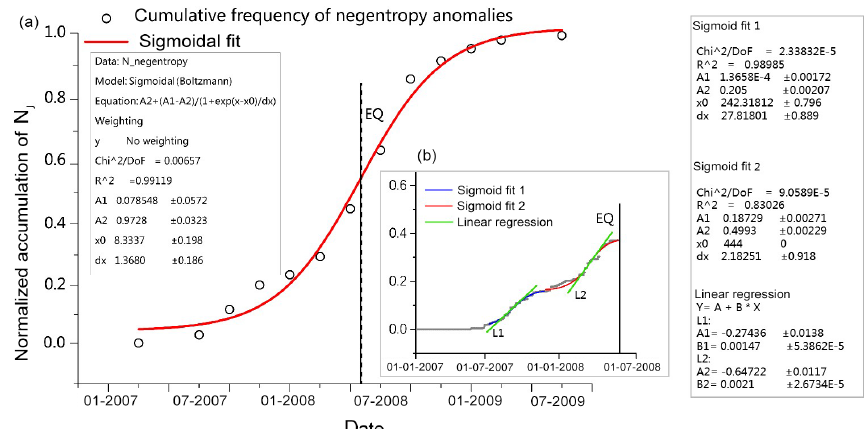
Figure 8. (a) Results of the long-term negentropy anomaly frequency for the Wenchuan earthquake at Guza station from 1 January 2007 to 30 June 2009. Each circle represents an anomaly negentropy for 2 months. The cumulative frequency of negentropy anomaly is represented. The earthquake day is represented as a black vertical dashed line. The red line is a sigmoid fit that underlines an inflection point (vertical solid line) that is close to the occurrence of the earthquake. (b) Results of the short-term negentropy anomaly frequency prior to the earthquake. Every grey point is an anomaly for 1d, and the blue and red lines are two segment sigmoid fit results. Two green lines represent the liner regression for the two phases; the first phase slope is 0.00147, and the second one is 0.0021.